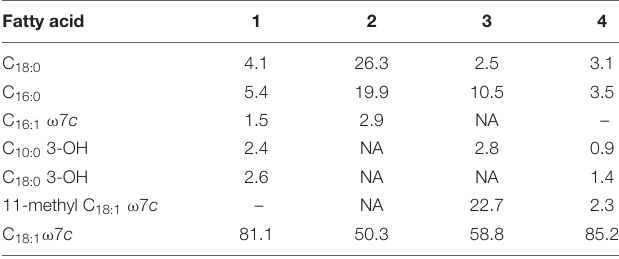
TABLE 3 | Cellular fatty acid profiles of strain D13-10-4-6 T and closely related type strains.